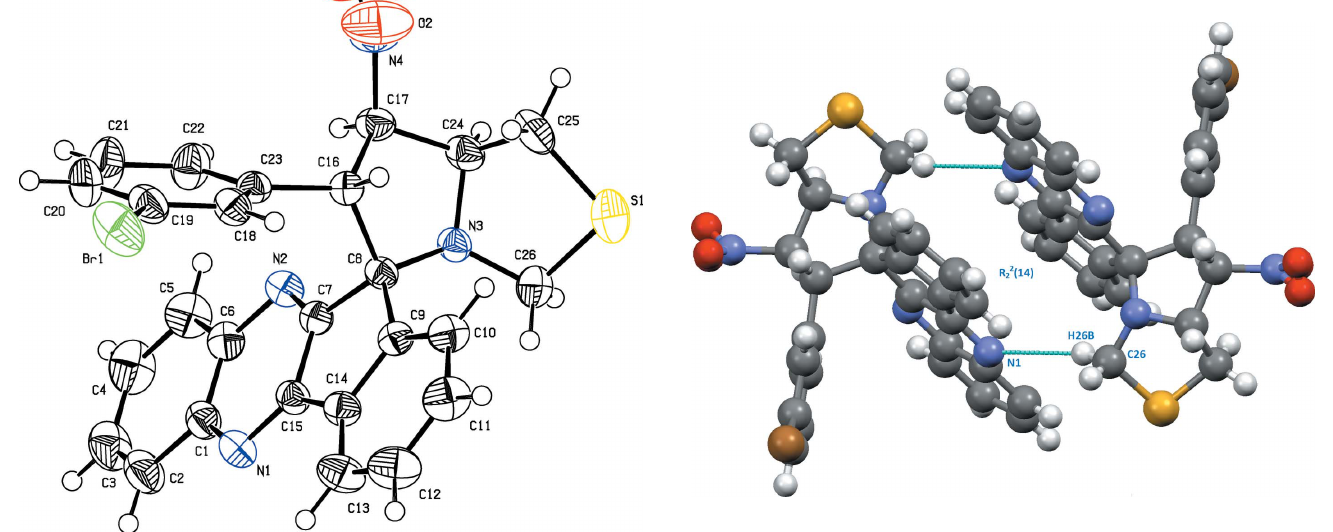
Figure 1 The structure of the title compound with the atom numbering. Displacement ellipsoids are shown at the 50% probability